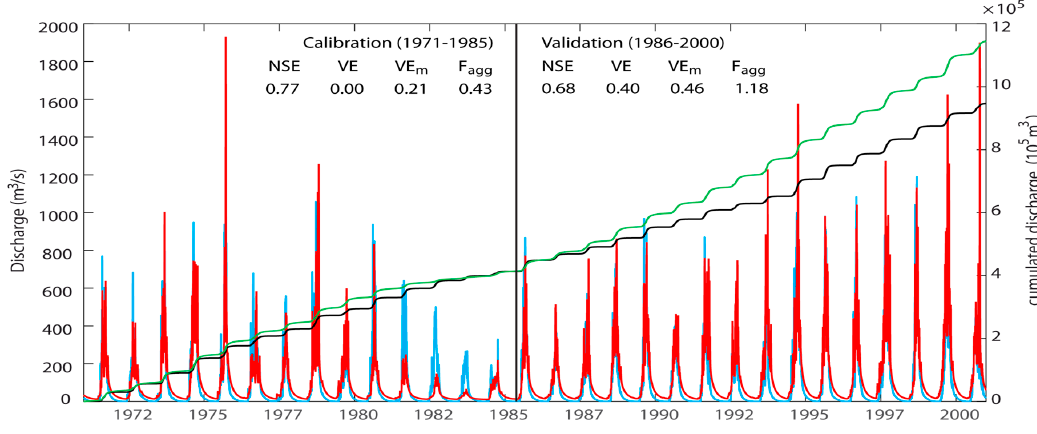
Figure 3. Comparison of observed and simulated hydrographs at Mako station (NSE is the Nash Sutcliffe coefficient, VE is the cumulative volume error, VE m is the yearly mean volume error, and F agg is the multi-criteria aggregating function).